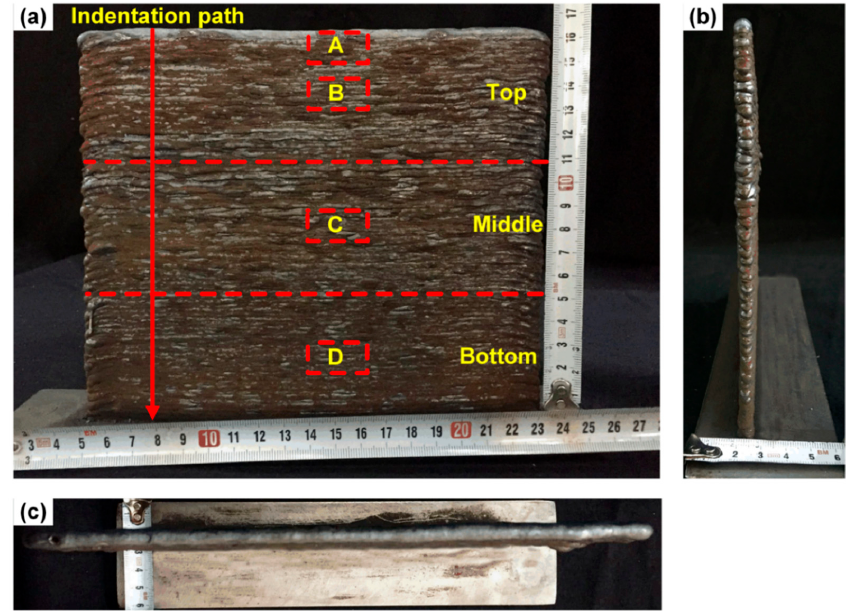
Figure 4. The single bead wall using XC-45 wire as deposited with WAAM, ( a ) main view, ( b ) side view, ( c ) top view. (under the deposition parameters listed in Table 2).